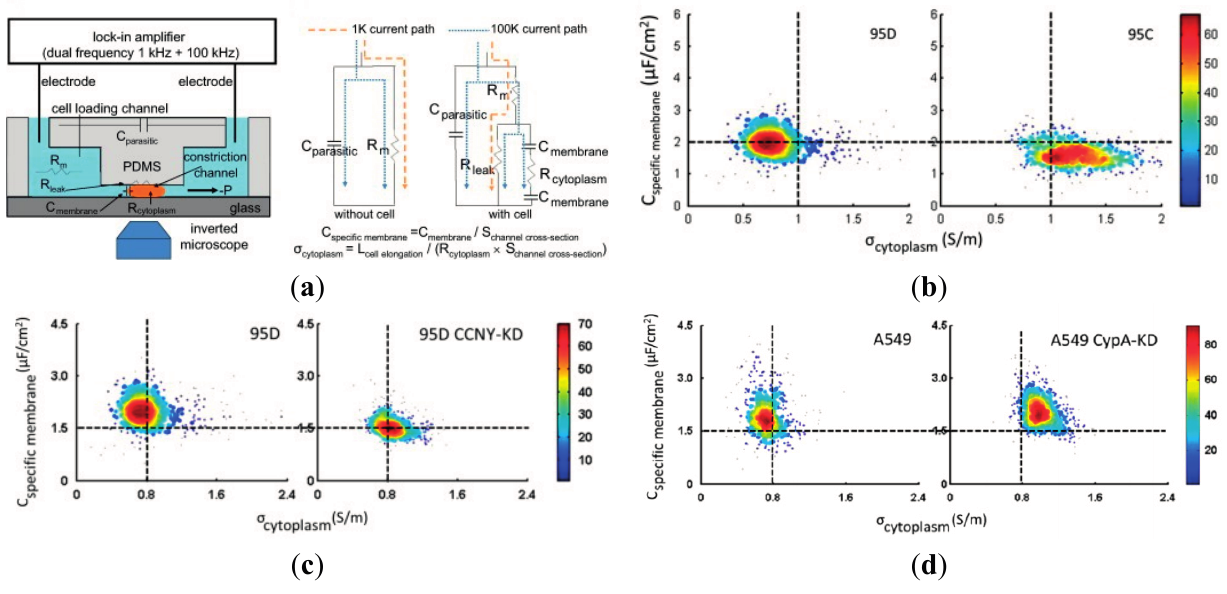
Figure 5. ( a ) The microfluidic impedance flow cytometry for continuous characterization of specific membrane capacitance (C specific membrane ) and cytoplasm conductivity ( σ cytoplasm ) of single cells. Cells are aspirated continuously through the constriction channel with impedance data at 1 and 100 kHz measured simultaneously where 1 kHz impedance data were used to evaluate cellular sealing properties with constriction channel walls while 100 kHz impedance data were used to quantify C specific membrane and σ cytoplasm [85]; ( b ) For paired high- and low-metastatic carcinoma strains 95D and 95C cells, significant differences in both C specific membrane and σ cytoplasm were observed; ( c ) A statistically significant difference only in C specific membrane was observed for 95D cells and 95D CCNY-KD cells with single oncogene CCNY down regulation (CCNY is a membrane-associated protein); ( d ) A statistically significant difference only in σ cytoplasm was observed for A549 cells and A549 CypA-KD cells with single oncogene CypA down regulatio n (CypA is a cytosolic protein)